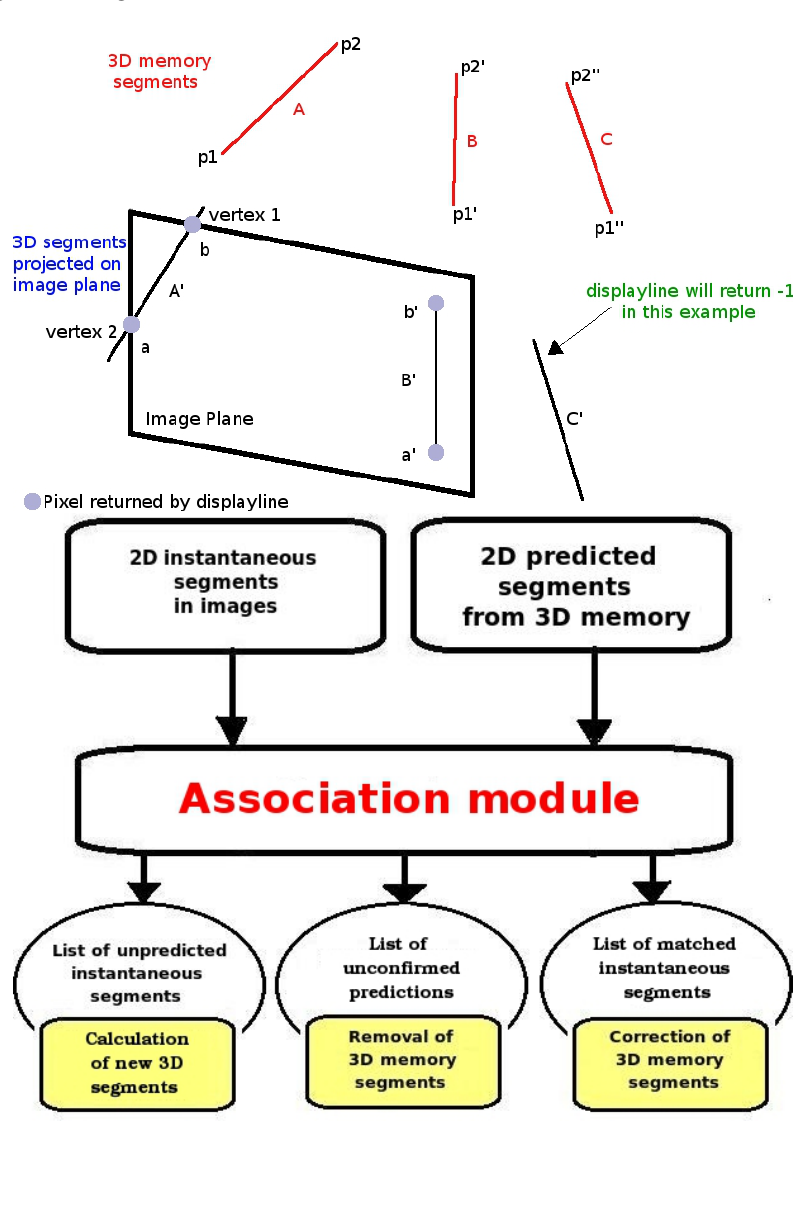
Figure 4. 3D projection on the image plane (left) and matching between predicted and observed segments